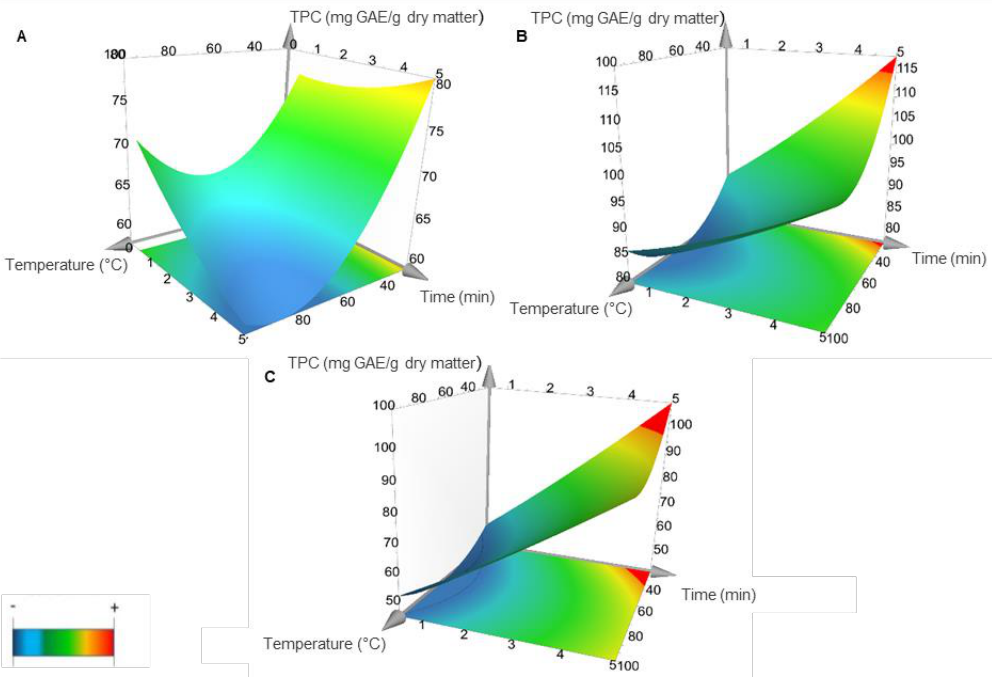
Figure 1. Response surface plot representing the effects of time, temperature and solvent ratio on Total Phenolic Content (TPC) from saffron floral by-products. ( A ) Ethanol concentration was kept constant at 0%. ( B ) Ethanol concentration was kept constant at 50%. ( C ) Ethanol concentration was kept constant at 100%. Lower values are represented in blue and higher values in red.